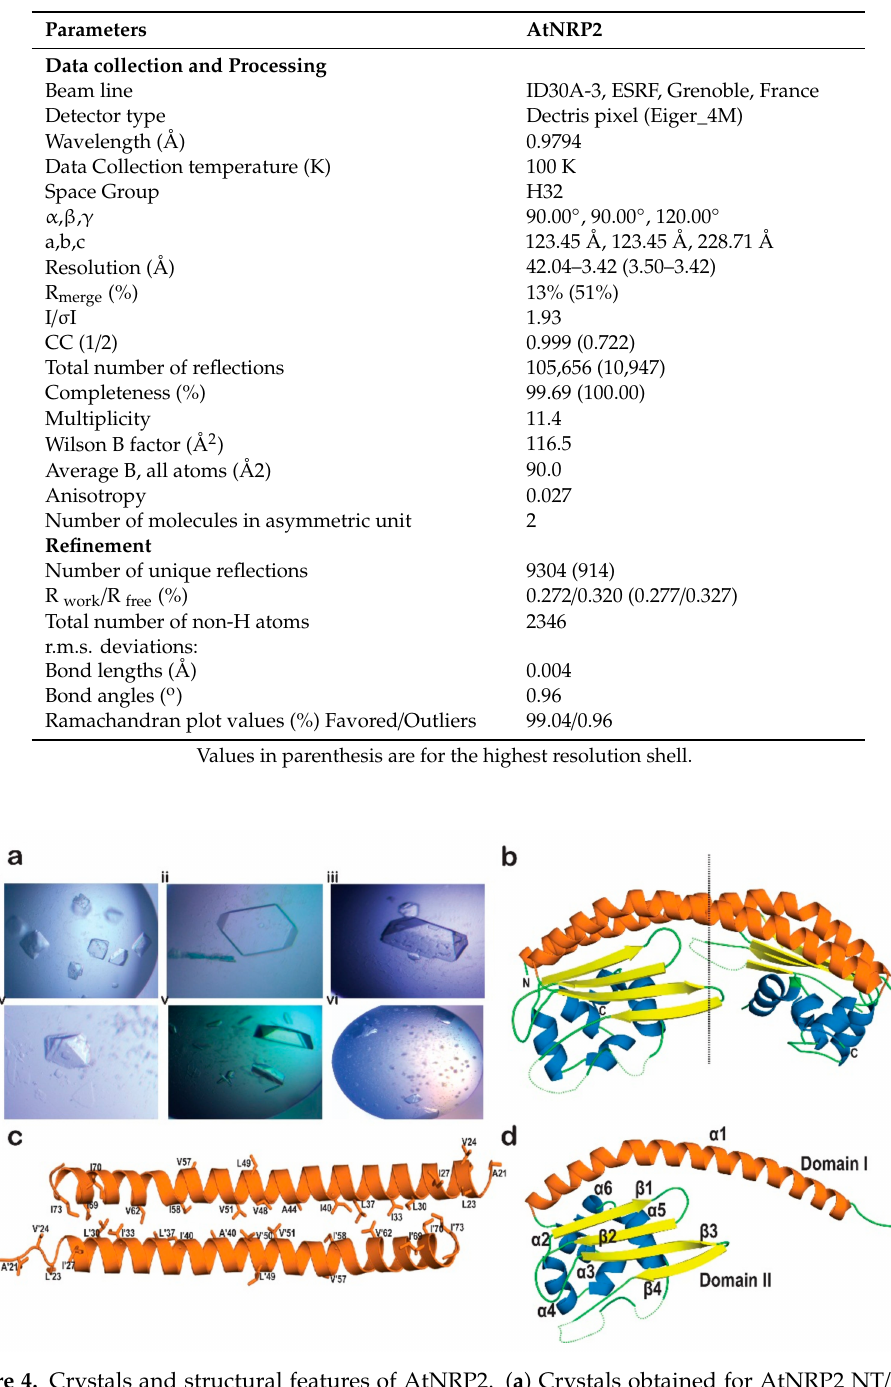
Figure 4. Crystals and structural features of AtNRP2. ( a ) Crystals obtained for AtNRP2 NT / CT in AmSO4 Suite (Qiagen) and tested for di ff raction (Conditions (i) 3, (ii) 25, (iii) 27, (iv) 32, (v) 40, (vi) 91). All the crystals were tested for di ff raction limits. The best di ff raction data was obtained for the big crystal from condition 27, and the collected data was used for structure work. ( b ) The crystal structure of AtNRP2, showing the pseudo-symmetric two-fold axis. ( c ) The distribution of hydrophobic residues along the long dimerization helix of AtNRP2. ( d ) The structure of AtNRP2 monomer, showing the domain organization, where domain I consist of a long dimerization helix ( α 1) and domain II includes both α -helices and β